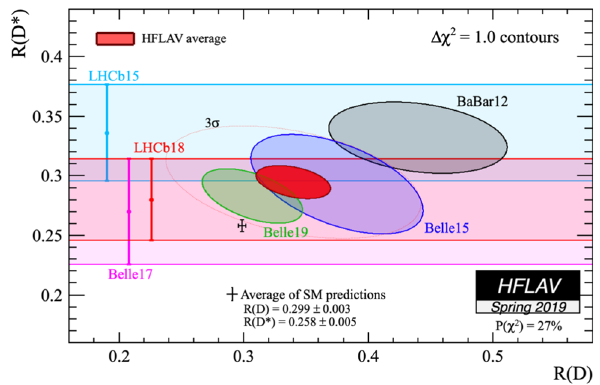
Fig. 3 Experimental results for the LFU ratios R ( D ( ∗ ) ) and their aver- age, provided by the HFLAV collaboration. The SM prediction is indi- cated by the black cross. From Ref.